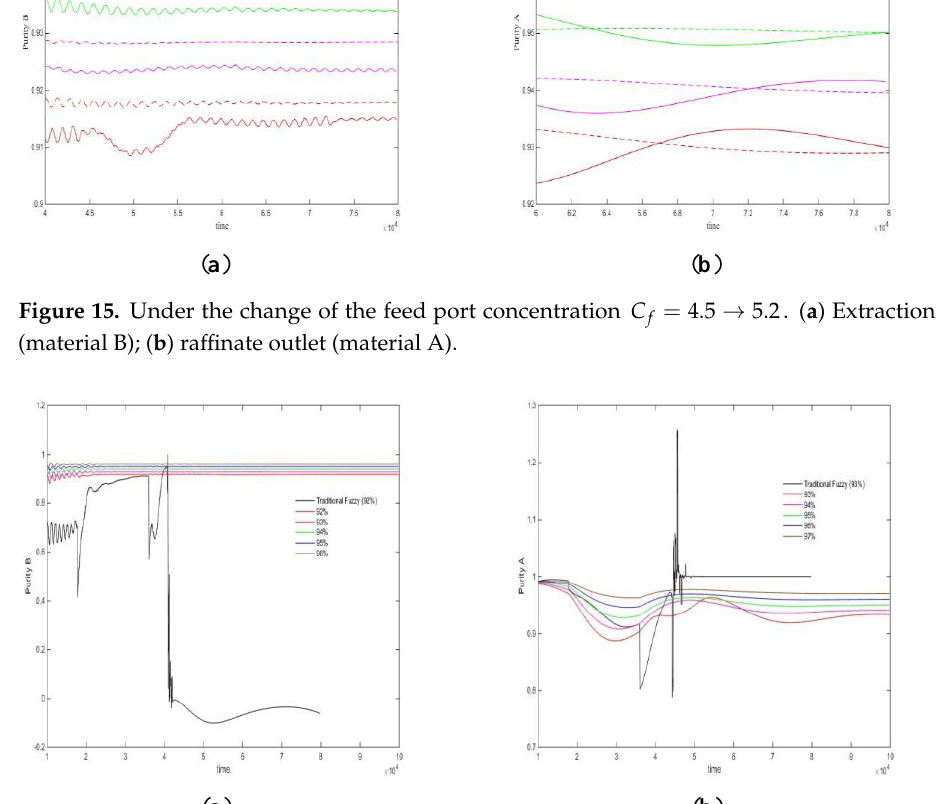
Figure 16. Under the change of the switch time θ = 178 s → 182 s . ( a ) Extraction outlet (material B); ( b ) raffinate outlet (material A).